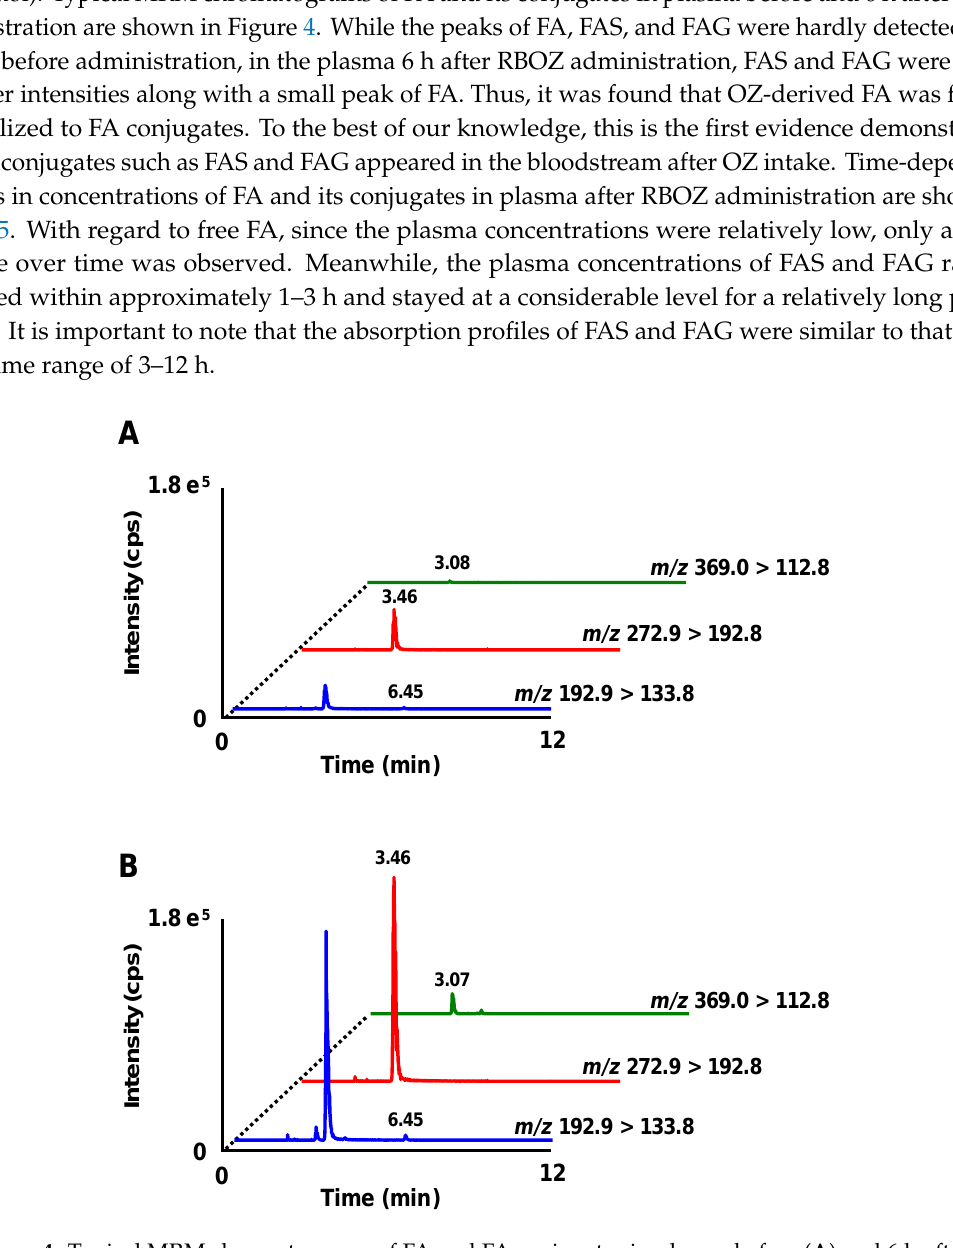
Table 1. The area under the plasma concentration-time curve (AUC; expressed as nmol·hour/L) and relative to the proportion of OZ molecular species in plasma after RBOZ administration.